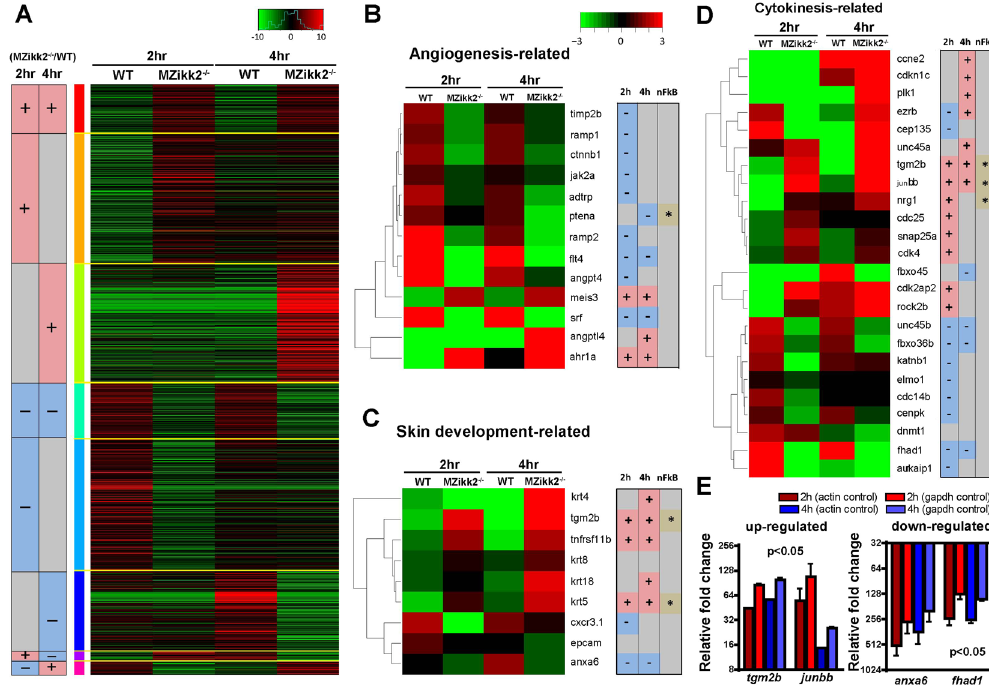
Figure 6. RNAseq analysis of transcriptome of wild-type and MZikk2 − / − embryos (obtained from homozygotic parents) reveals novel molecular targets regulated by Ikk2. ( A – D ) Green - down regulated in ikk2 − / − as compared to wild type control, red - up regulated in ikk2 − / − as compared to wild type control. ( A ) Heat maps illustrating total stage- and gene-specific expression trends. ( B ) Comparison of expression of angiogenesis- related genes. ( C ) Comparison of expression of skin-related genes. ( D ) Comparison of expression of cytokinesis-related genes. ( E ) Real-time PCR (qPCR) verification of selected target genes identified by RNAseq. Two internal reference, actb (actin) and gapdh were used for normalization. Data quantification was done by using the ΔΔ Ct method and the result was presented as a relative fold change compared to wild-type embryos at 2 and 4 hpf. Data are expressed as mean ± SEM, p < 0.05 for all four genes